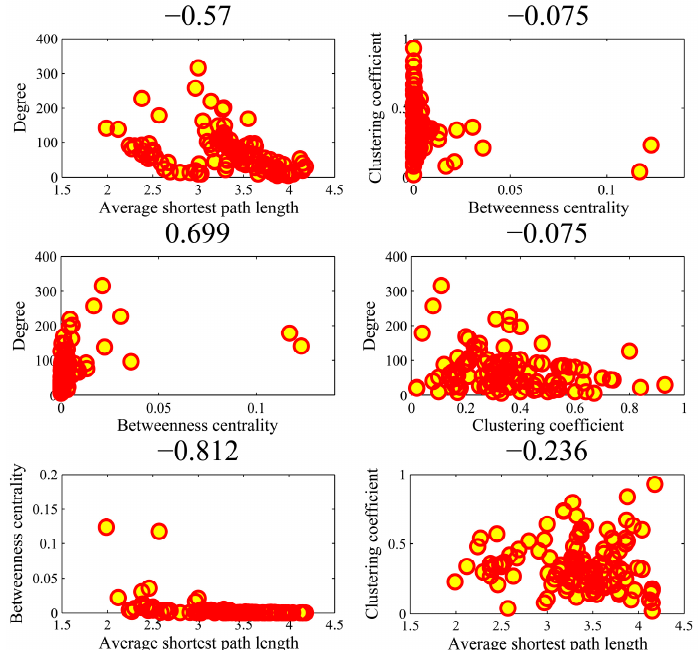
Figure 12. The Spearman rank correlations between the four parameters in the HCC (hepatocellular carcinoma) genes. carcinoma)